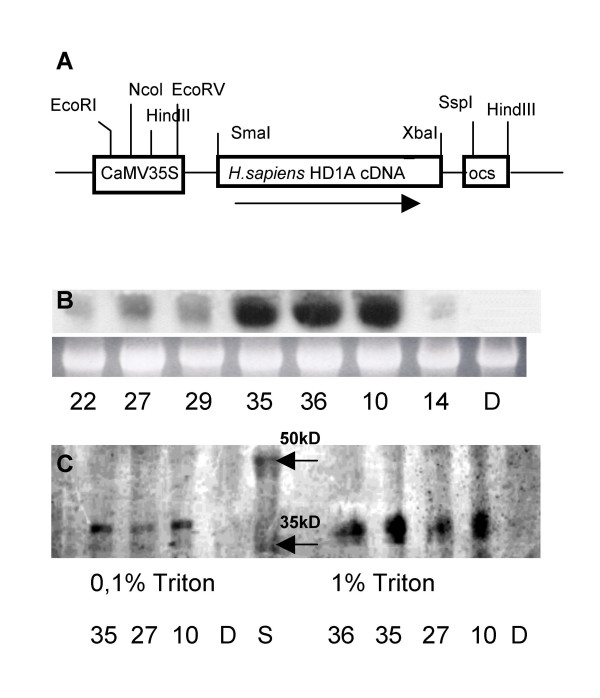
Selection of transgenic HD1 plants. Potato plant transformed with pHD1-BinAR construct carrying a cDNA for human dopamine receptor under the control of the CaMV 35S promoter (A) were selected by northern blot analysis (B). Lines showing the highest expression were further submitted to western blot analysis. For this purpose proteins were extracted with 0.1% or 1% Triton (C) and 50 μg of protein extract was run on 12% SDS polyacrylamide gel. D refers to control plants, numbers to different transgenic lines and S to Full Range Rainbow Molecular Weight Marker RPN 800 (Amersham Bioscience).